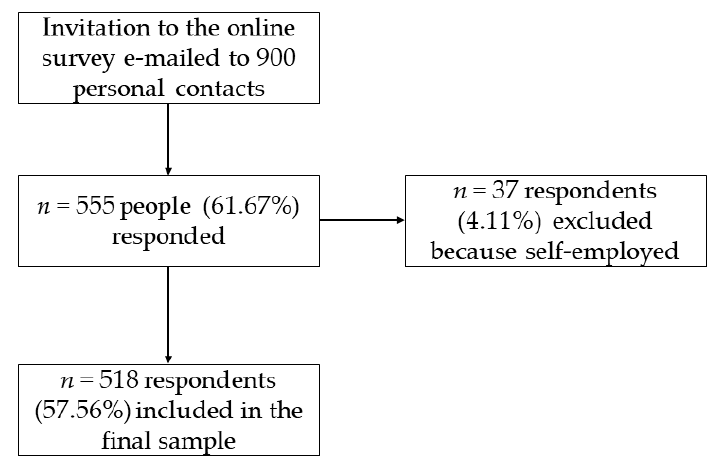
Figure 1. Flowchart of survey respondents.